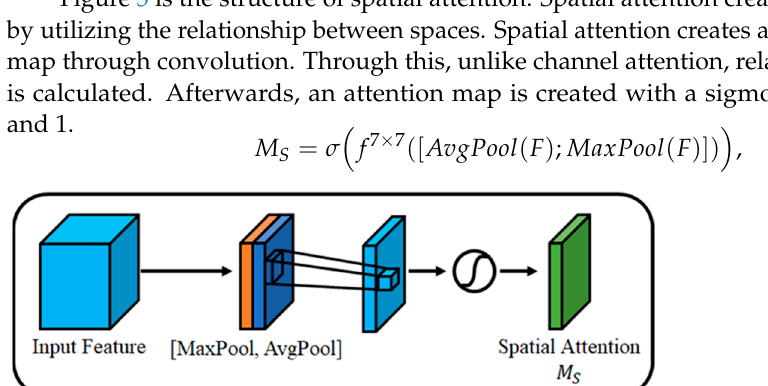
Figure 5. Spatial Attention Module.